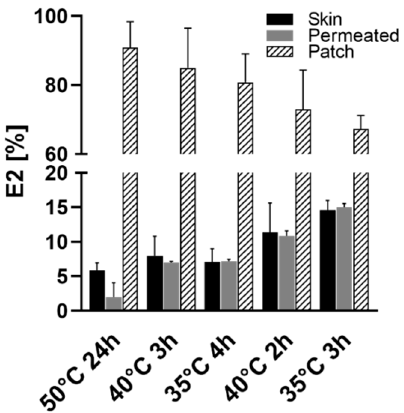
Figure 5. ( A ) Correlation between steady-state flux (J ss E2) of estradiol and DMSO per patch (R 2 = 0,972). ( B ) Correlation between steady-state flux of DMSO (J ss DMSO) and DMSO per patch (R 2 = 0,924). ( C ) Correlation between steady-state flux of estradiol (J ss E2) and steady-state flux of DMSO (Jss DMSO) (R 2 = 0.884). ( D ) Correlation between kinetic release rate of estradiol (J ss E2) and steady-state flux of estradiol (J ss E2) (R 2 ≤ 0.5). * Indicates significant differences ( p < 0.05), ** indi- cates significant differences ( p < 0.01) and *** indicates significant differences ( p < 0.001).